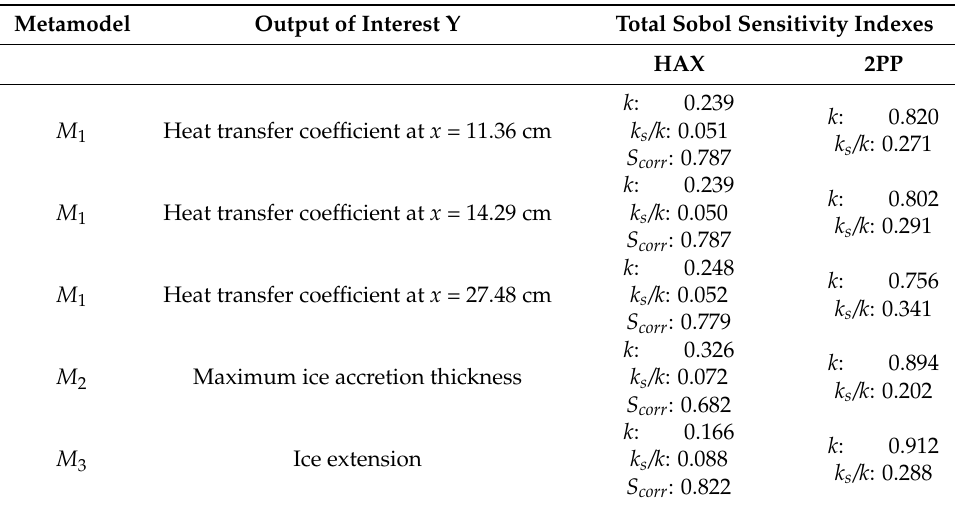
Table 6. Total Sobol sensitivity indexes for each metamodel.